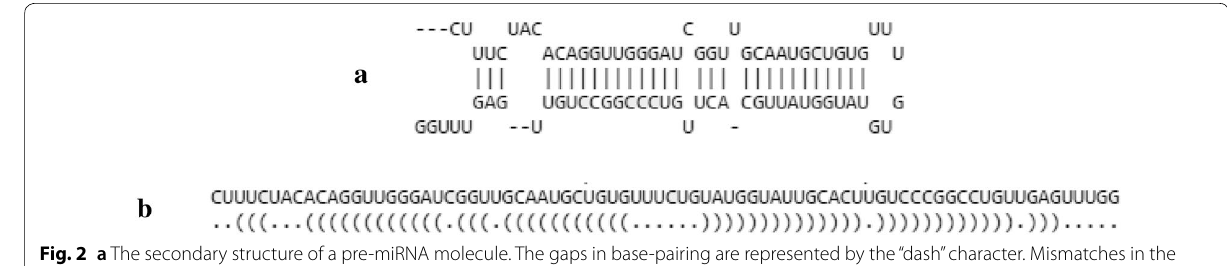
Fig. 2 a The secondary structure of a pre-miRNA molecule. The gaps in base-pairing are represented by the “dash” character. Mismatches in the stem part that lead to unpaired bases can be seen. The loop is shown at the rightmost part of the molecule. b The first line represents the primary structure of the pri-miRNA shown in a and the second line indicates the “dot-bracket notation” of the same